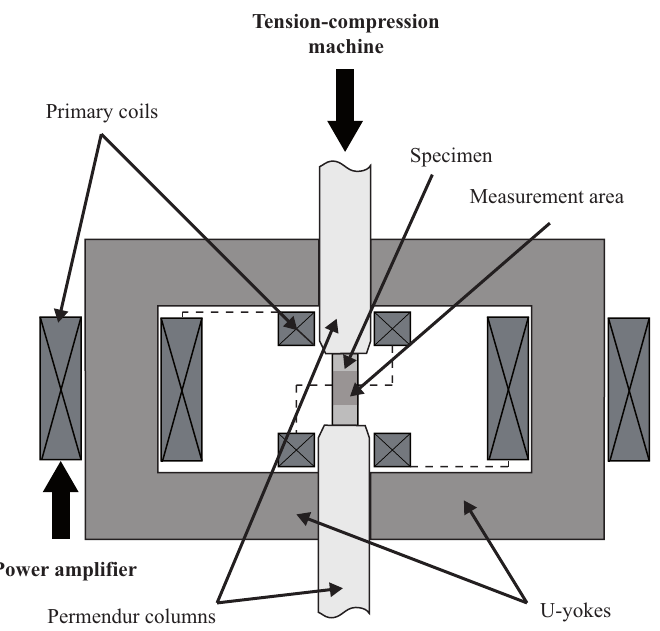
Figure 1. Magneto-mechanical characterisation